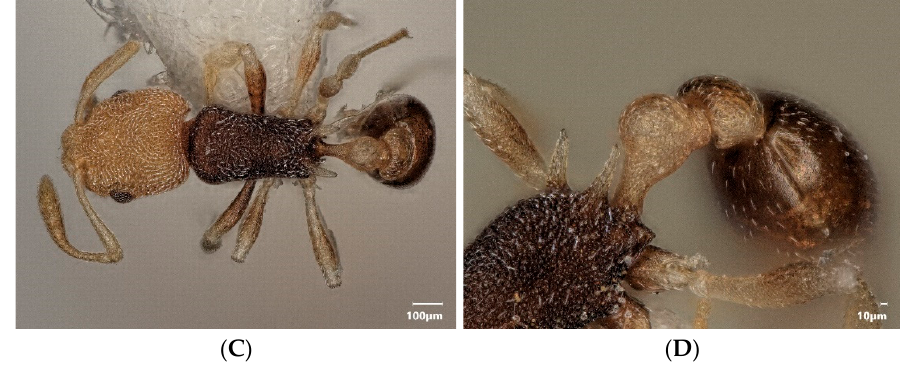
Figures 11. Cardiocondyla semiargentea n.sp.: paratype, head in dorsal view ( A ) , lateral view ( B ), dorsal view ( C ) waist in frontolateral view ( D ).